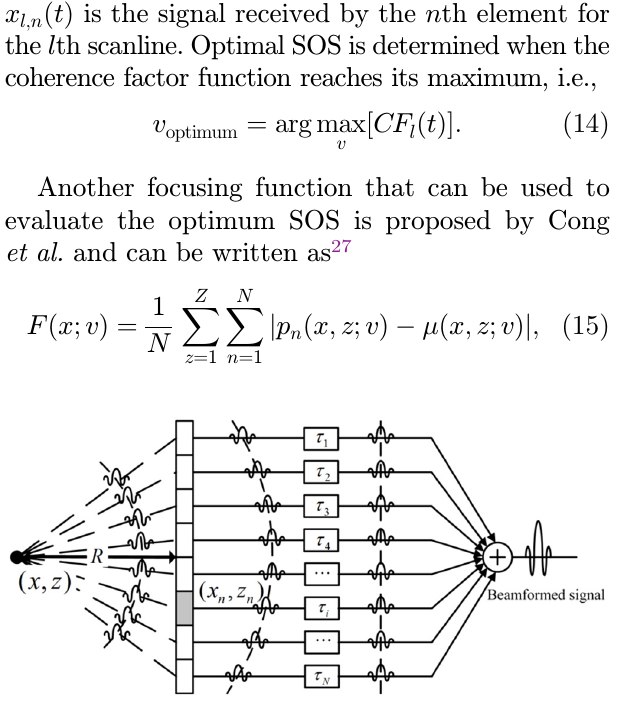
Fig. 6. Schematic showing that PA signals generated from a point-like absorber are received by a detector array when the assumed sound speed is equal to the true one. Reproduced with permission from Ref.